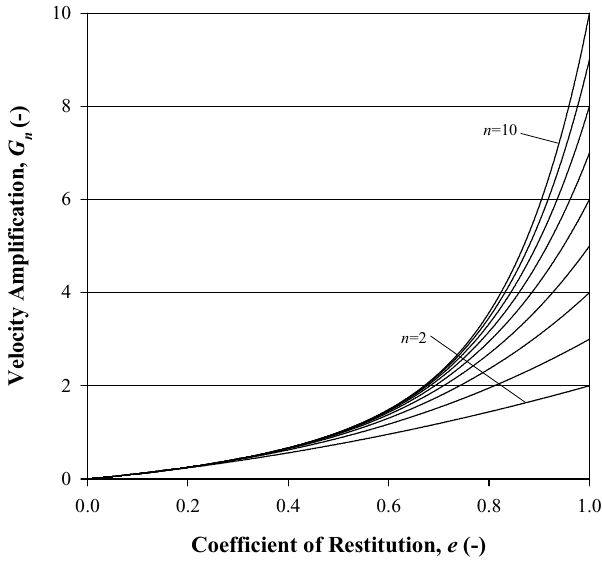
Fig. 11. Velocity amplification of the uppermost mass in vertically-stacked MET chains, consisting of two to ten masses, as a function of coefficient of restitution. (-) means non-dimensional. illustrate that for values of e significantly less than 1, G max n is modest and achieved with fairly short chains.